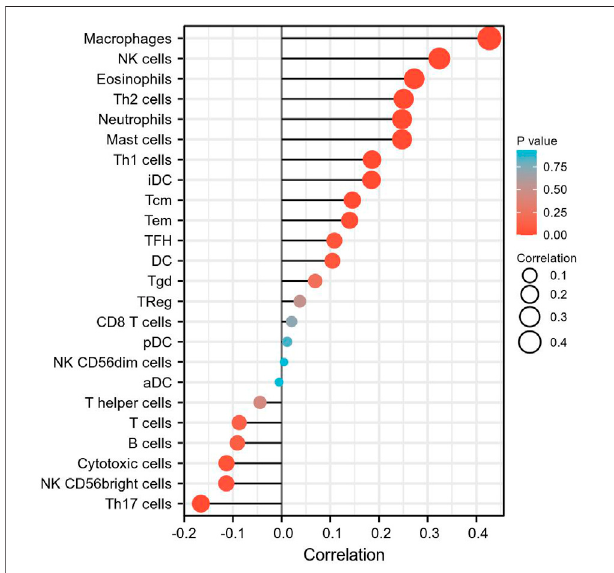
FIGURE 8 | Immune cells postively correlated with INHBA expression. (A) Correlation between INHBA expression and Macrophages. (B) Correlation between INHBA expression andMastcells. (C) Correlationbetween INHBA expression and NK cells. (D) Correlationbetween INHBA expression andNeutrophils. (E) Correlation between INHBA expression and Th2 cells. (F) Correlation between INHBA expression and Eosinophils.